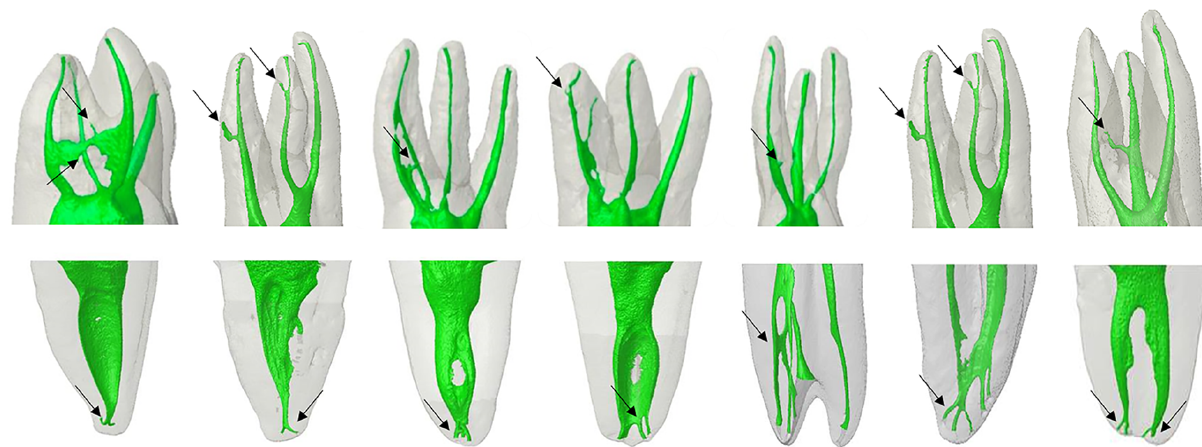
Figure 1- 3D models of maxillary and mandibular teeth showing the morphology of the root canal system according to the root thirds. The presence of main, accessories, lateral, secondary, collateral, intercanal, recurrent and reticular canals, and apical deltas was indicated by black arrows